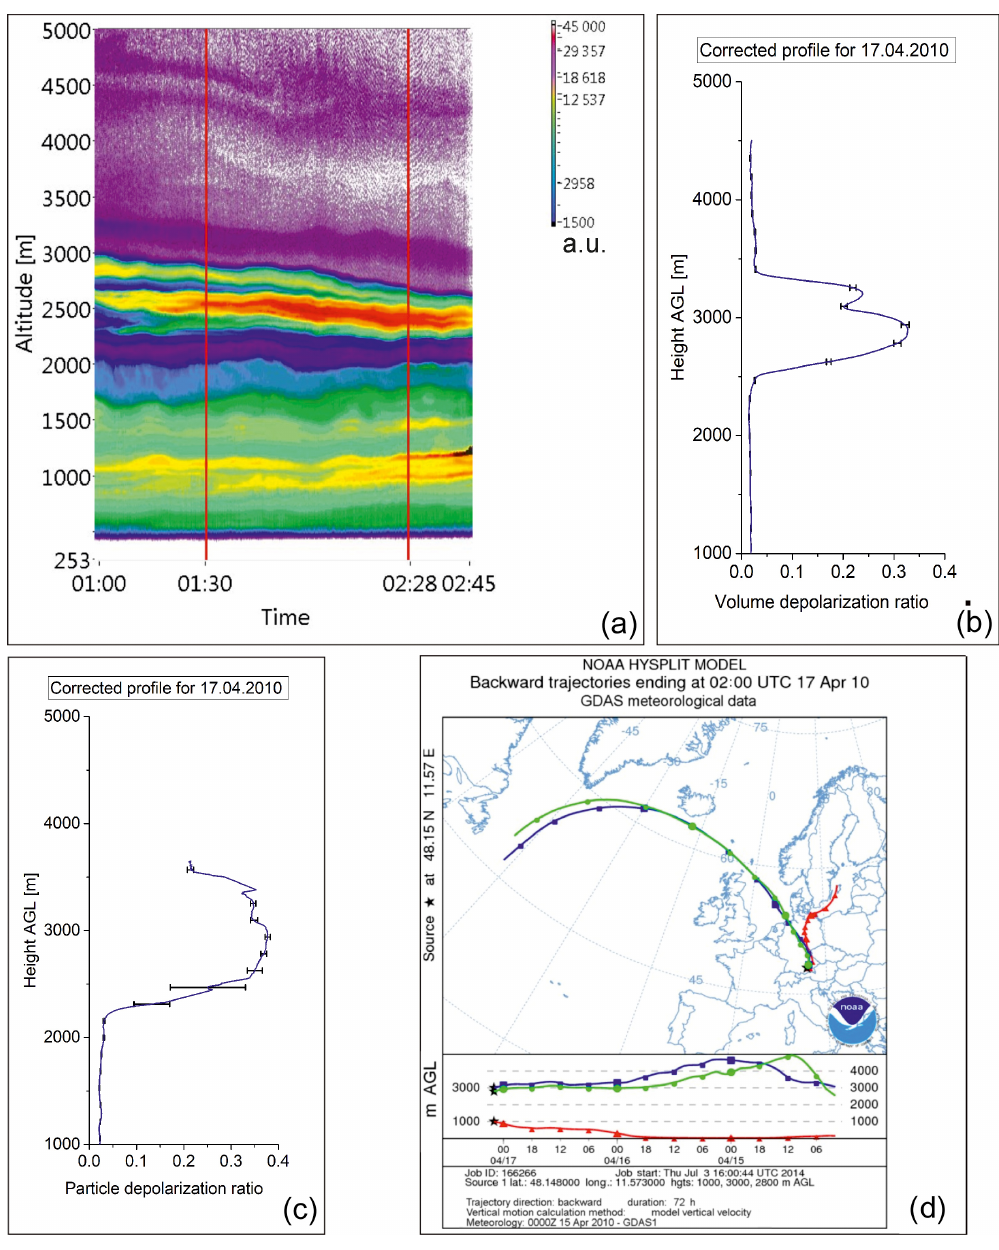
Figure 11. Data from 17 April 2010, at the Maisach-Munich lidar system (a) range-corrected time series at 532nm; (b) volume linear depolarization ratio is a corrected profile at 532nm – smoothed data, 1h average, 45m vertical smoothing; (c) particle linear depolarization ratio is a corrected profile at 532nm – smoothed data, 1h average, 45m vertical smoothing; (d) HYSPLIT back-trajectory analysis ( − 72h) for the detected layers at the Munich